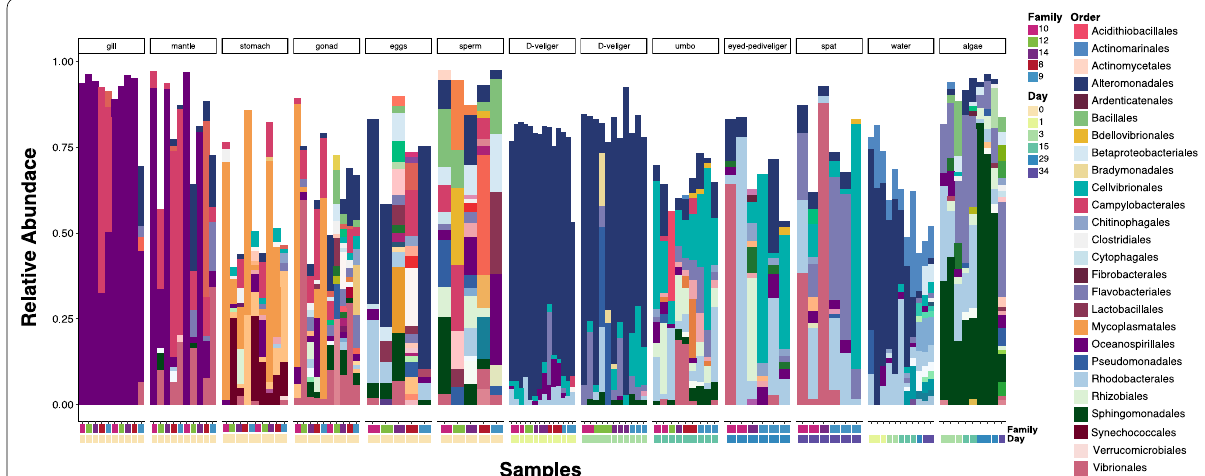
Fig. 1 Stacked bar plot of the relative abundance of bacterial orders comprising microbial communities associated with oyster tissues (gill, mantle, stomach, gonad, gametes and larvae) and their environment (water and algae). Relative abundance was calculated within each sample and ASVs that made up less than 1% of the sample were excluded